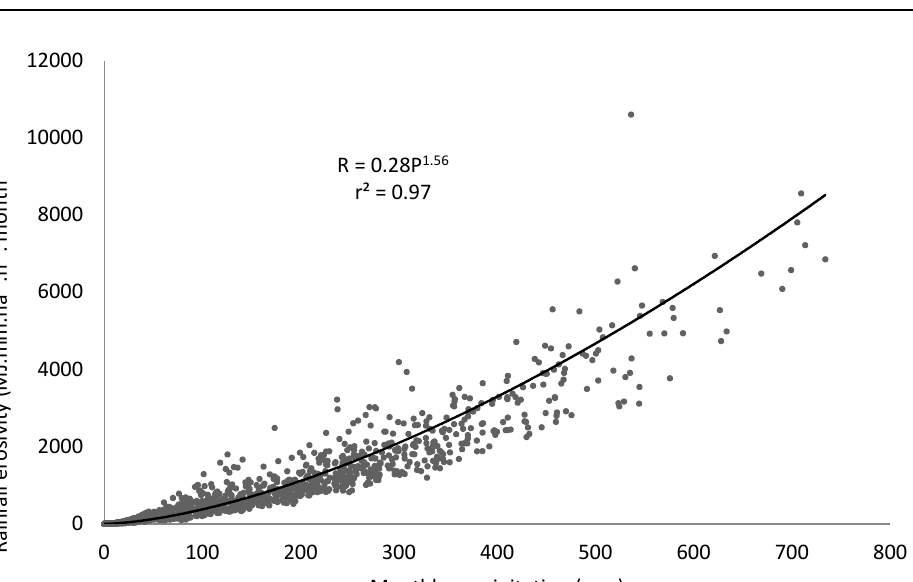
R = 0.28P 1.56 r² = 0.97